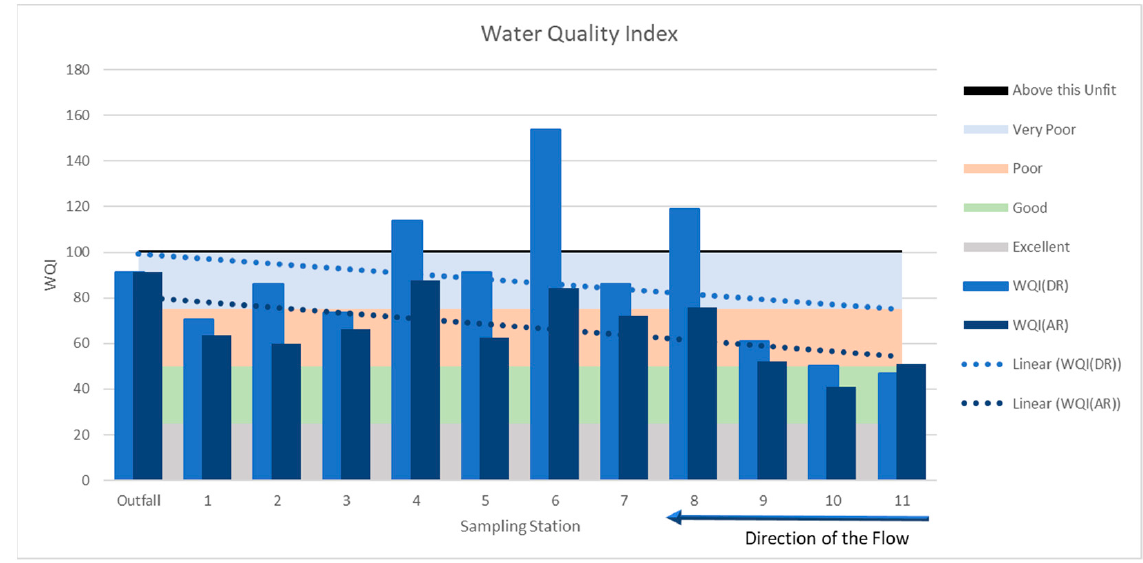
Figure 6. Water Quality Index at sampling stations. Table 2. Mean values and standard deviation of the parameters analyzed.